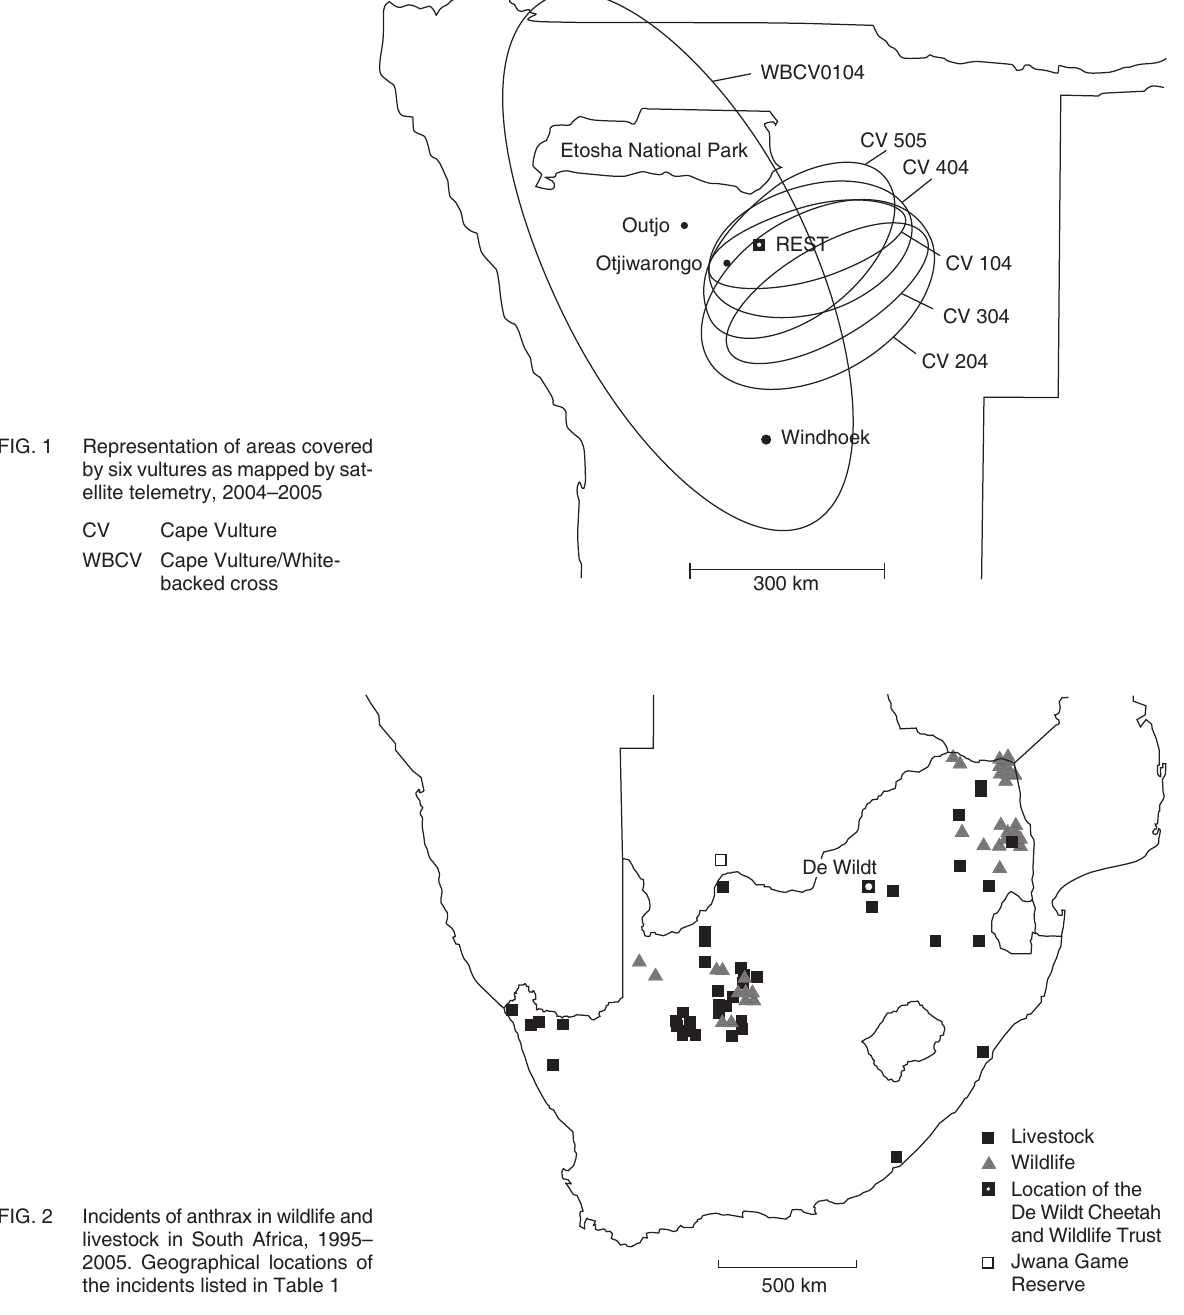
FIG. 1 Representation of areas covered by six vultures as mapped by sat- ellite telemetry, 2004–2005